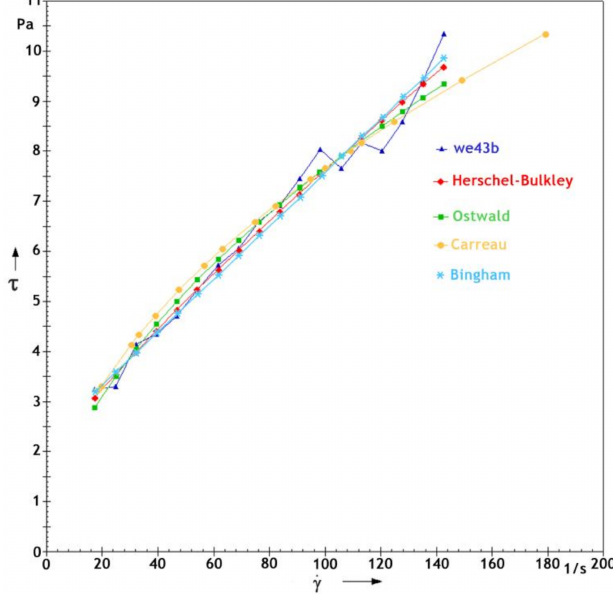
Figure 7. Flow curves for alloy WE43B: actual and computed from the Hershel-Bulkley ( R 2 = 0.97892), Ostwald ( R 2 = 0.97174), Carreau ( R 2 = 0.93052), and Bingham ( R 2 = 0.97731)